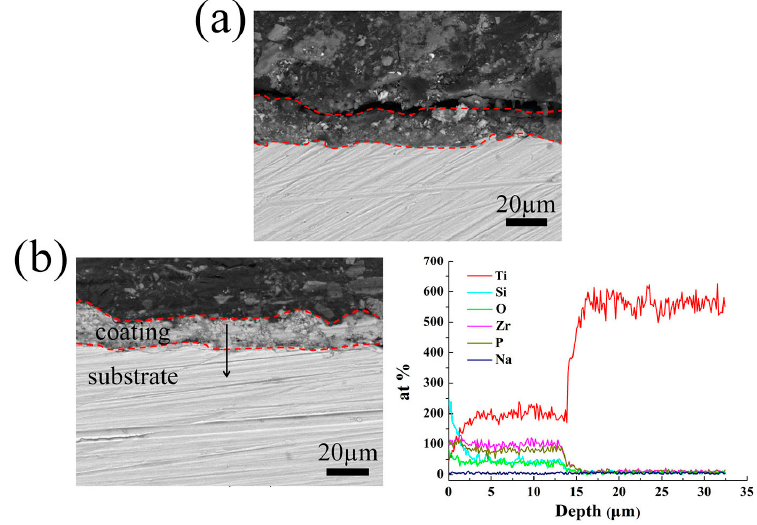
Figure 3. Cross-sectional morphologies and elemental distribution of the MAO coatings formed in different K 2 ZrF 6 concentrations: ( a ) 0 g/L; ( b ) 9 g/L.